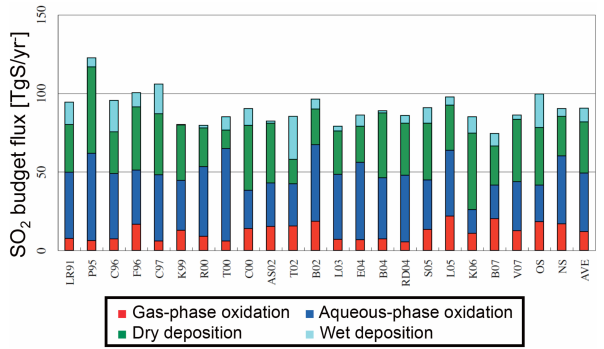
Fig. 8. Global annual mean SO 2 budget in this simulations: LR91 (Langner and Rodhe, 1991), P95 (Pham et al., 1995), C96 (Chin et al., 1996), F96 (Feichter et al., 1997), C97 (Chuang et al., 1997), K99 (Koch et al., 1999), R00 (Rasch et al., 2000), T00 (Takemura et al., 2002), C00 (Chin et al., 2000), AS02 (Adams and Seinfeld, 2002), T02 (Takemura et al., 2002), B02 (Boucher et al., 2002), L03 (Liao et al., 2003), E04 (Easter et al., 2004), B04 (Berglen et al., 2004), RD04 (Rodriguez and Daddub, 2004), S05 (Spracken et al. 2005), L05 (Liu et al., 2005), K06 (Koch et al., 2006), B07 (Bauer et al., 2007), and V07 (Verma et al., 2007), respectively. The NS and OS represent simulations in this study and the original SPRINTARS. The AVE represents averaged